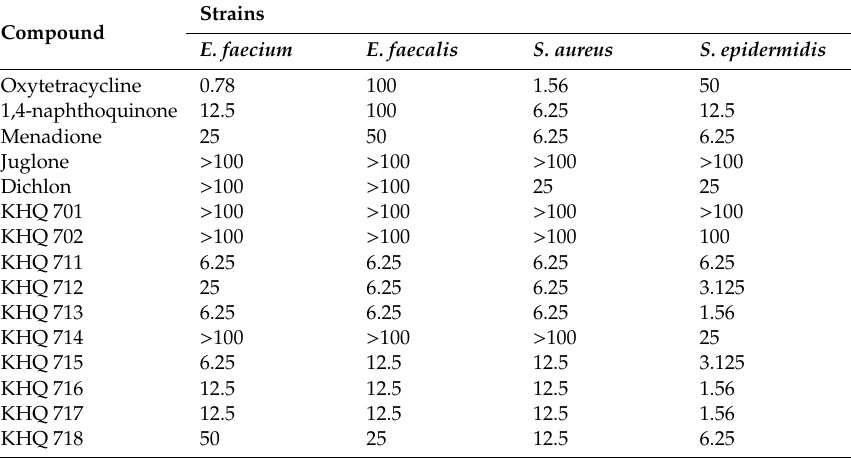
Table 2. Minimum inhibitory concentration (MIC) values ( µ g / mL) against oral bacteria.